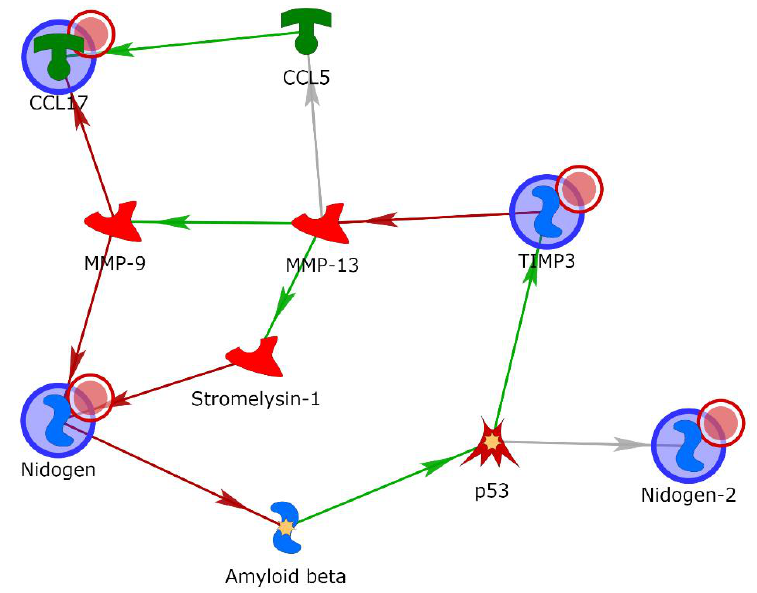
Figure 5. Gene network obtained with the shortest-path tool of Metacore TM for the proteins TARC, TIMP-3, NID1 and NID2, allowing for two intermediary molecules. Green arrows indicate activation, while red indicates inhibition. Gray arrows mean that the type of interaction is not yet clear. Table 2. List of protein interactions and related PubMed references obtained by the database